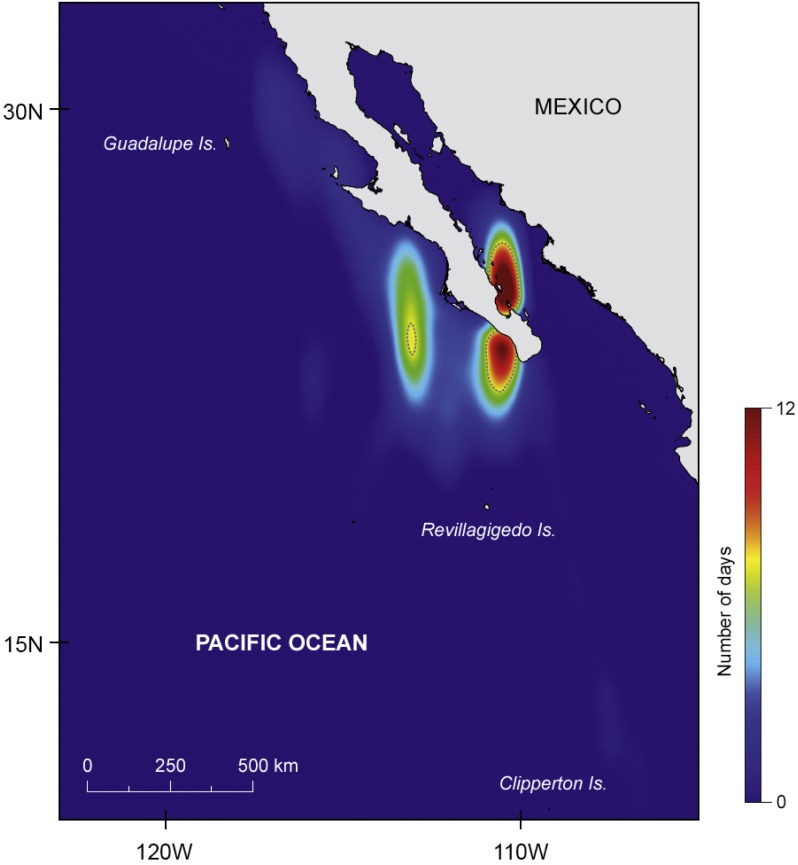
Major areas of residency.Kernel density plot (estimated using the coastline as a barrier) showing the two major areas of prolonged residency (in number of days), one inside the Gulf of California and another offshore; dashed line represents 95% isopleth.